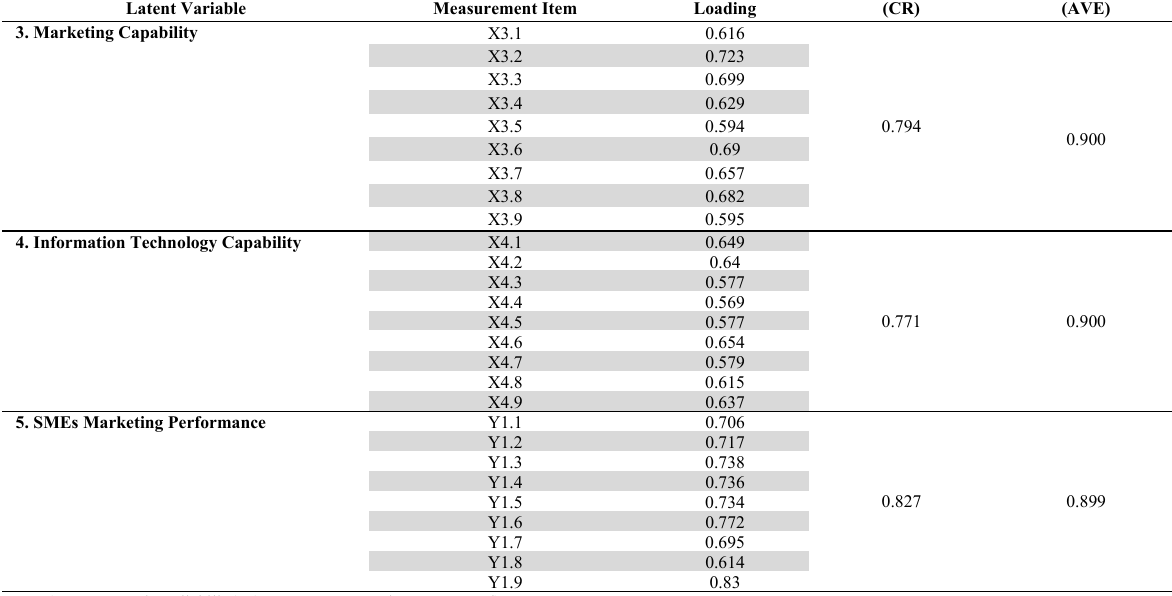
Convergent validity results (Continued) Latent Variable